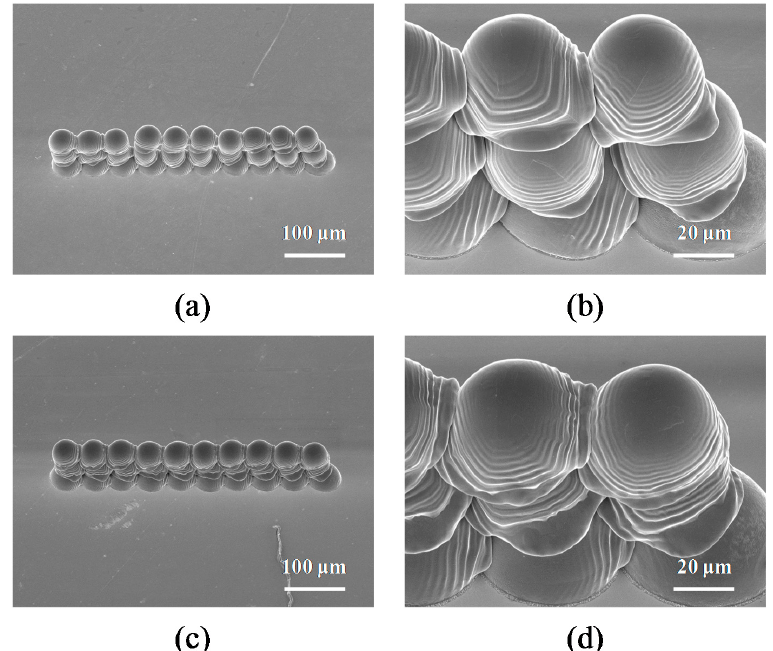
Figure 12. Tilted 40° SEM images of the deposited droplets when the substrate temperature is controlled, and the dot spacing and stage velocity are fixed at 50 μ m and 50 mm ∙ s − 1 (frequency = 1000 Hz), respectively. ( a ) 50 °C (Ste = 0.645), 200× magnification; ( b ) 50 °C (Ste = 0.645), 1000× magnification; ( c ) 70 °C (Ste = 0.567), 200× magnification; ( d ) 70 °C (Ste = 0.567), 1000× magnification.